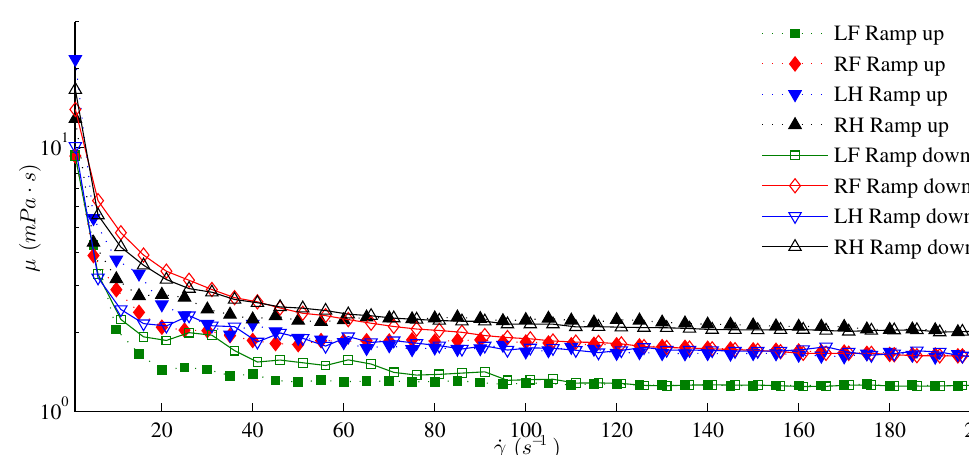
Figure 2. Evidence of time dependence for human milk flow properties. Shear Rate Loop Test demonstrates time dependence for human milk for both foremilk and hindmilk. Viscosity of milk from the right breast ended higher while milk from the left breast ended lower and shows inter-breast variation (see Section